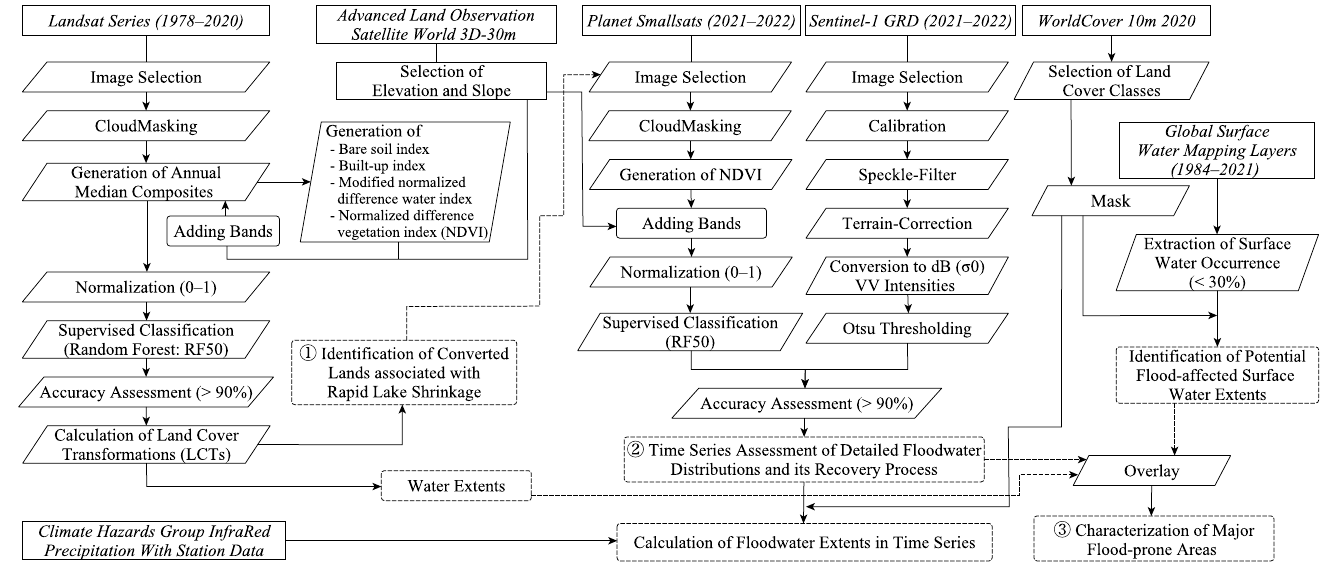
Figure 1. Overall methodological